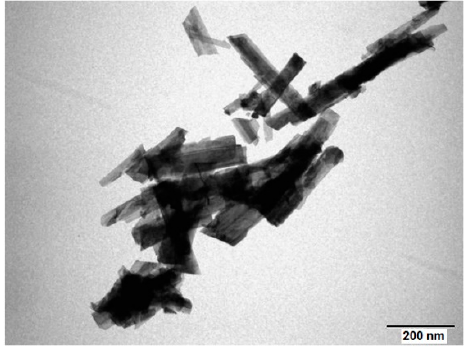
Figure 4. TEM images of Co 3 O 4 nanoparticles.